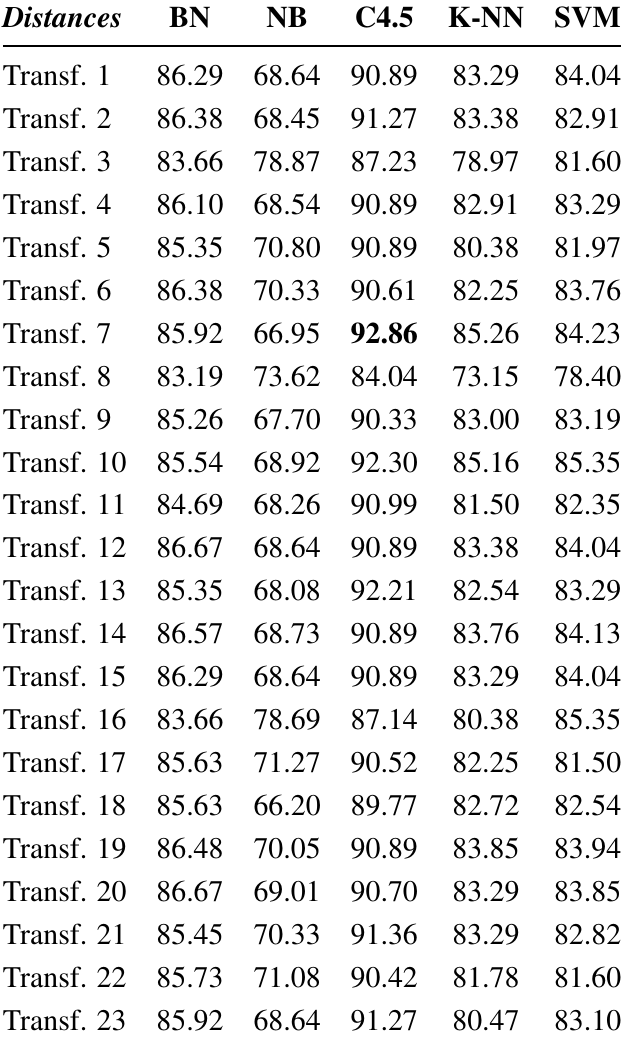
IK4-TEKNIKER depth images: 10-fold cross-validation accuracy percentage obtained for each classifier using each of the proposed